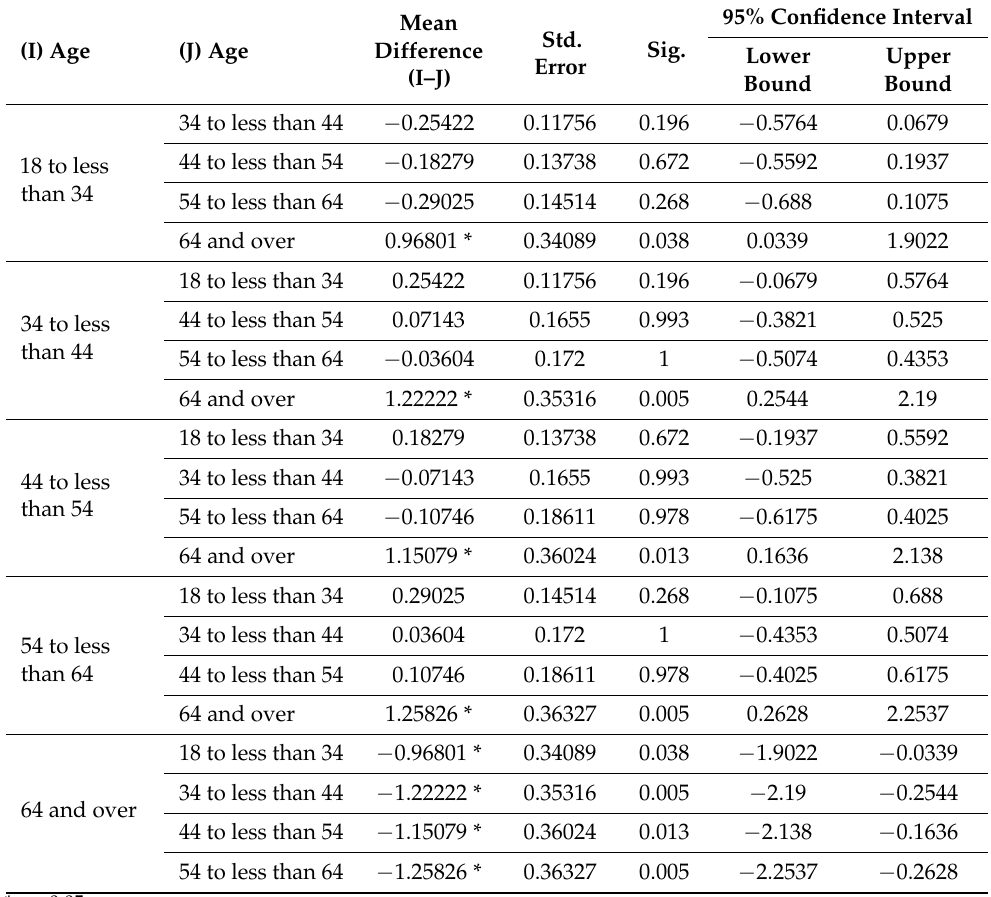
Table 10. Multiple comparisons analysis of the behavioral intention attributed to